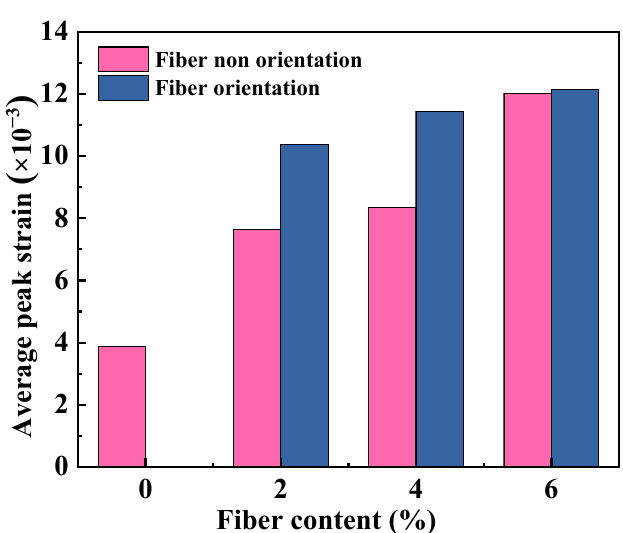
Figure 6. Effect of fiber content and orientation on peak strain.